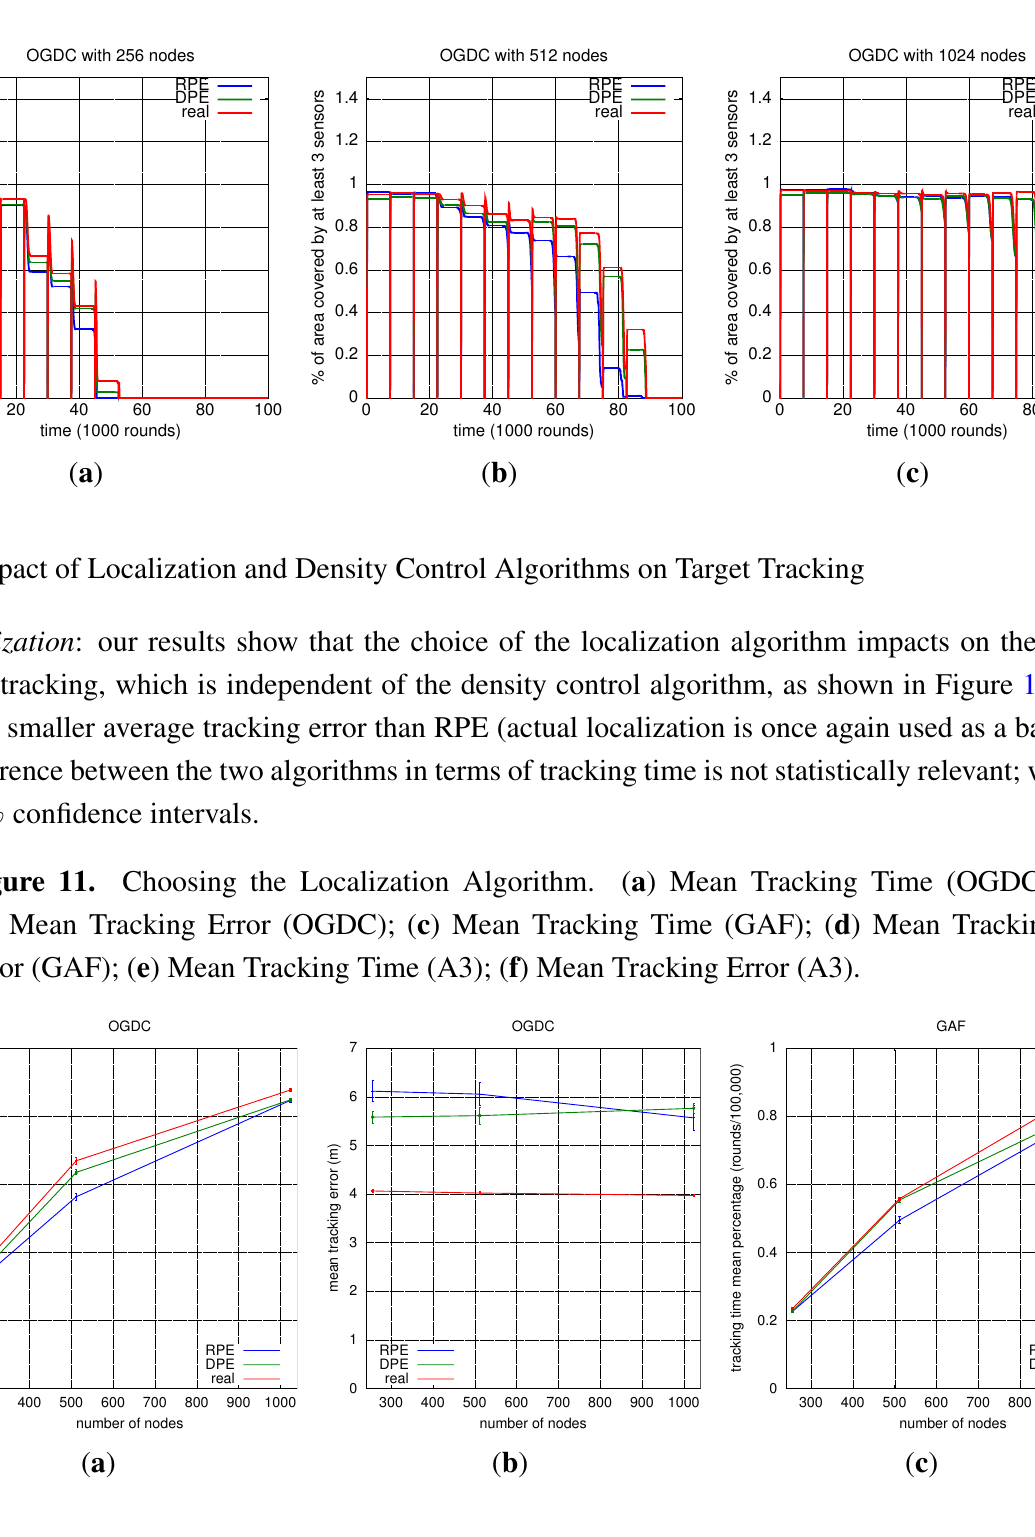
Figure 10. Localization and 3-Coverage of OGDC. ( a ) OGDC; n = 256 ; ( b ) OGDC; n = 512 ; ( c ) OGDC; n = 1024 .